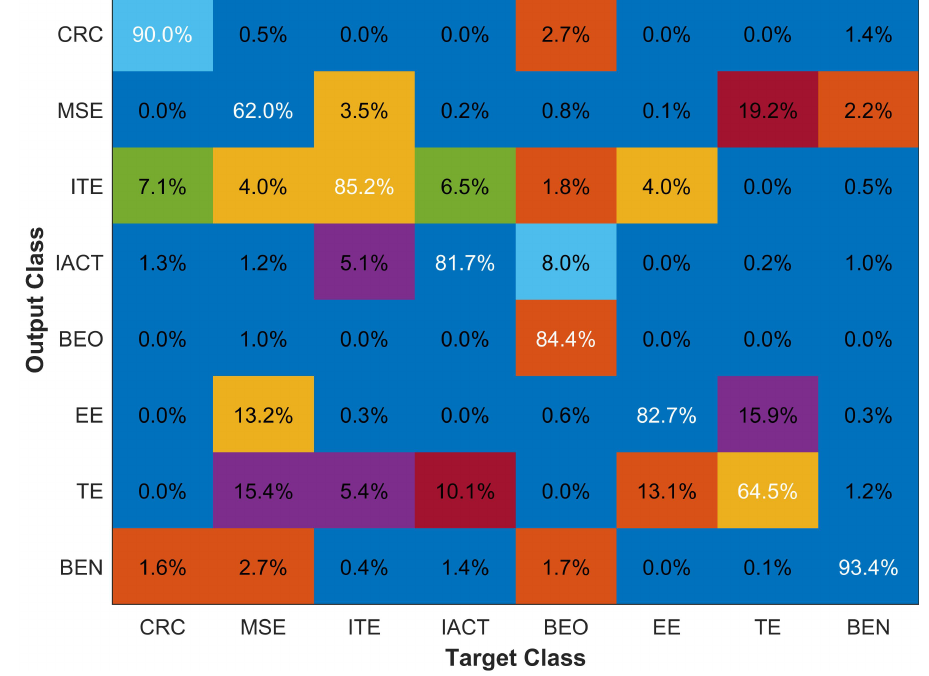
Figure 11. Classification results with eight